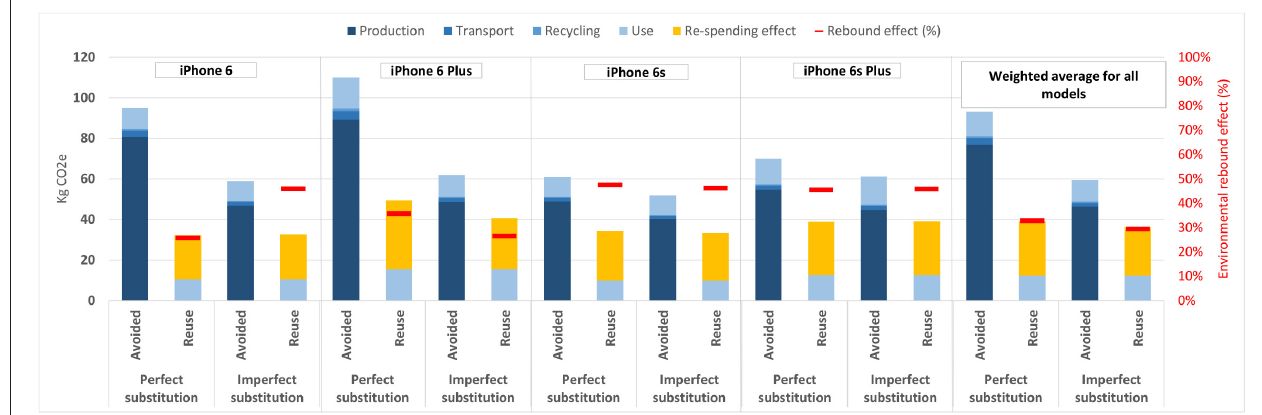
FIGURE 1 | Life cycle greenhouse gas (GHG) emissions (in CO 2 e, left axis) and environmental rebound effect (in %, right axis) for smartphone reuse, by iPhone model and substitution scenario (perfect vs. imperfect). Perfect substitution scenario assumes 1:1 substitution ratio between used and new phones of identical model and make. Imperfect substitution assumes a mix of alternative substitutes (including new and used smartphones as well as avoided purchases) weighted by our survey results. “Reuse” emissions are those associated with reusing a smartphone, whereas “avoided” emissions are those associated with its alternative(s). GHG emissions are broken down according to the production, transport, recycling, and use phases. Re-spending corresponds to emissions resulting from the economic savings of purchasing a used smartphone instead of its corresponding alternative(s). The “average” model represents a weighted average of all four iPhone models by their eBay sales volume. The rebound effect is expressed as the % of GHG emission savings that are offset due to